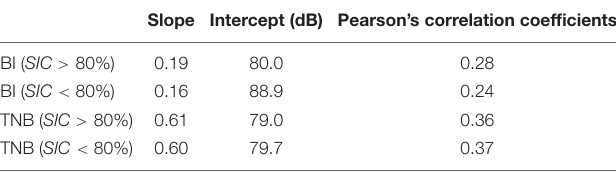
TABLE 3 | Slope, intercept, and correlation coefficients for linear fits between sound levels in 50–65 Hz and wind speed for sea-ice concentration data greater than 80% and less than